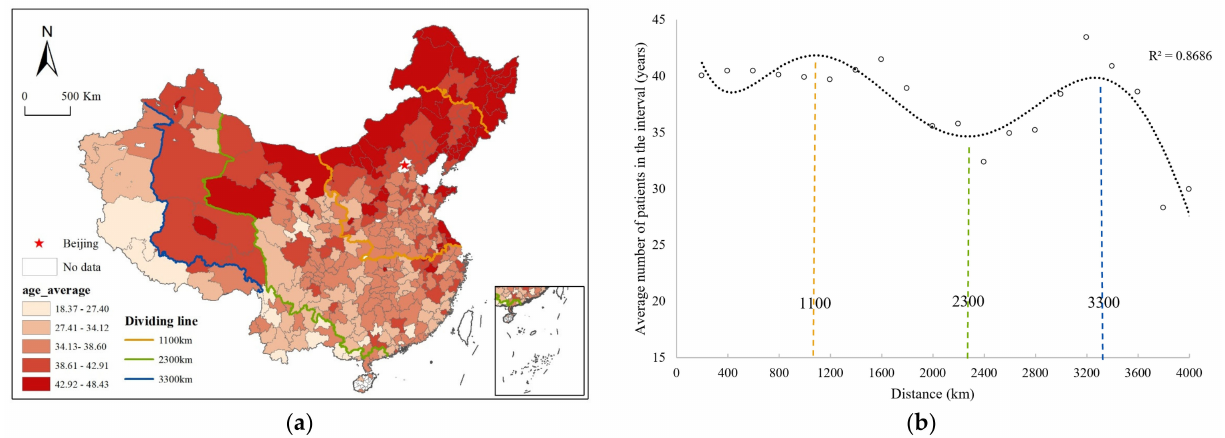
Figure 6. Spatial characteristics of the cross-regional patients’ age. ( a ) The average age distribution of patients travelling from each city to Beijing. ( b ) The scatter plot of distance and average